Question: Write a single sentence explaining what this figure depicts.
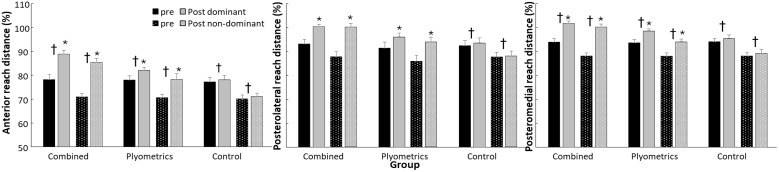
Answer: Mean (95% CI) reach distance related to leg length in anterior, posterolateral and posteromedial direction for dominant and non-dominant leg at pre and posttest for each group. * indicates a significant difference with the pretest. † Indicates a significant difference with the other two groups from pre- to post test.